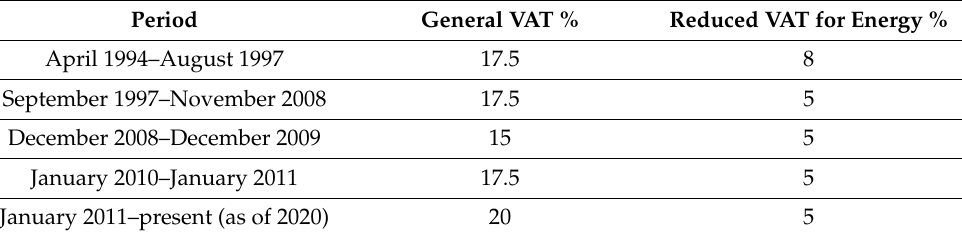
Table 5. VAT and energy taxation of the UK, 1994 to 2011. Period General VAT % Reduced VAT for Energy % April 1994–August